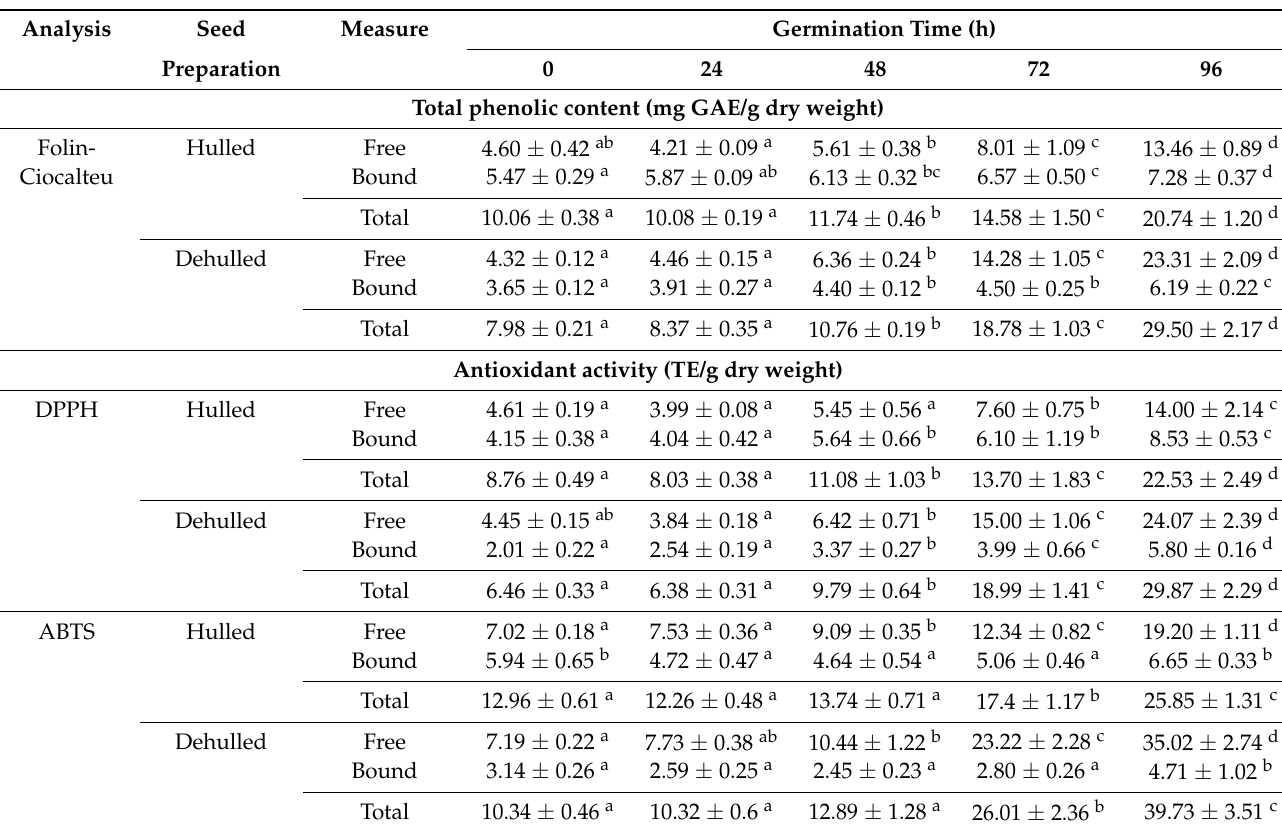
Table 1. Total phenolic content (Folin-Ciocalteu) and antioxidant activities (1,1-diphenyl-2-picrylhydrazyl (DPPH), 3- ethylbenzothiazolin-6-sulfonic acid diammonium salt (ABTS)) for the free and bound extraction fractions of the buckwheat seeds during